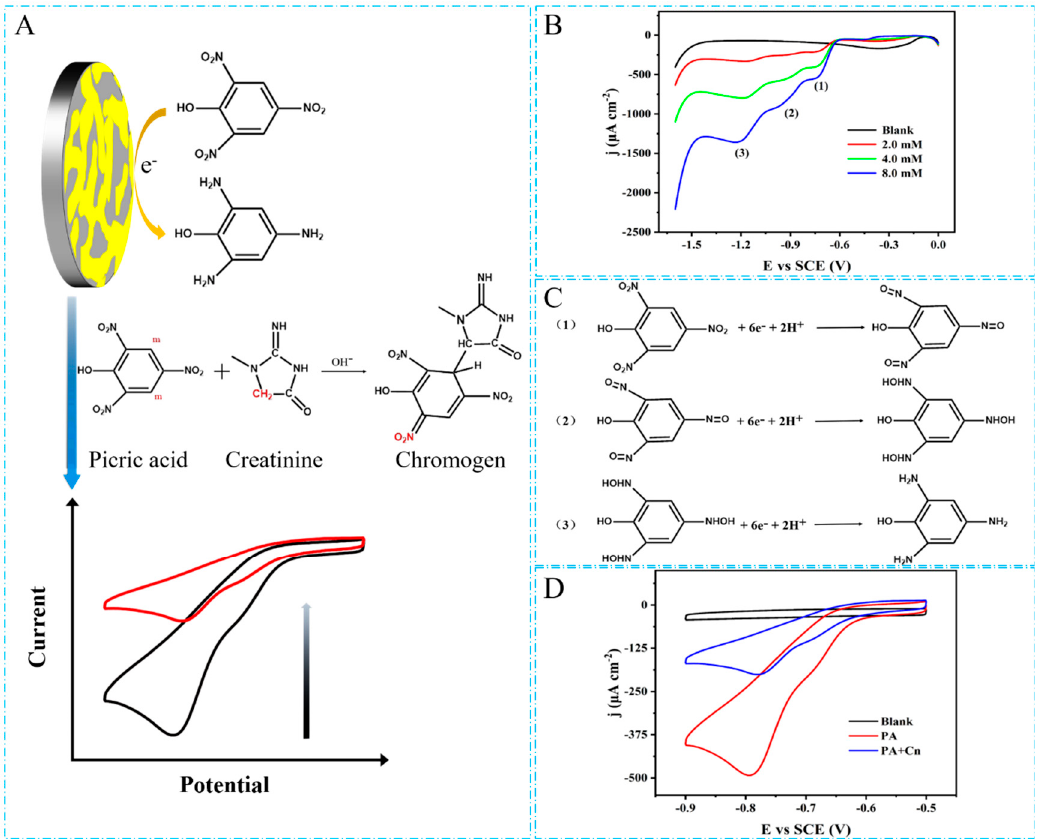
Figure 4. ( A ) Catalytic reduction of picric acid by the NPG/GCE and Jaffé reaction between picric acid and creatinine under alkaline conditions. ( B ) The CV curves of the NPG/GCE in NaOH (0.2 M) containing picric acid (2.0 mM, 4.0 mM, and 8.0 mM) at a scan rate of 50 mV s − 1 . ( C ) The specific reaction mechanism of picric acid catalyzed by NPG. ( D ) The CV response of picric acid before and after adding creatinine.